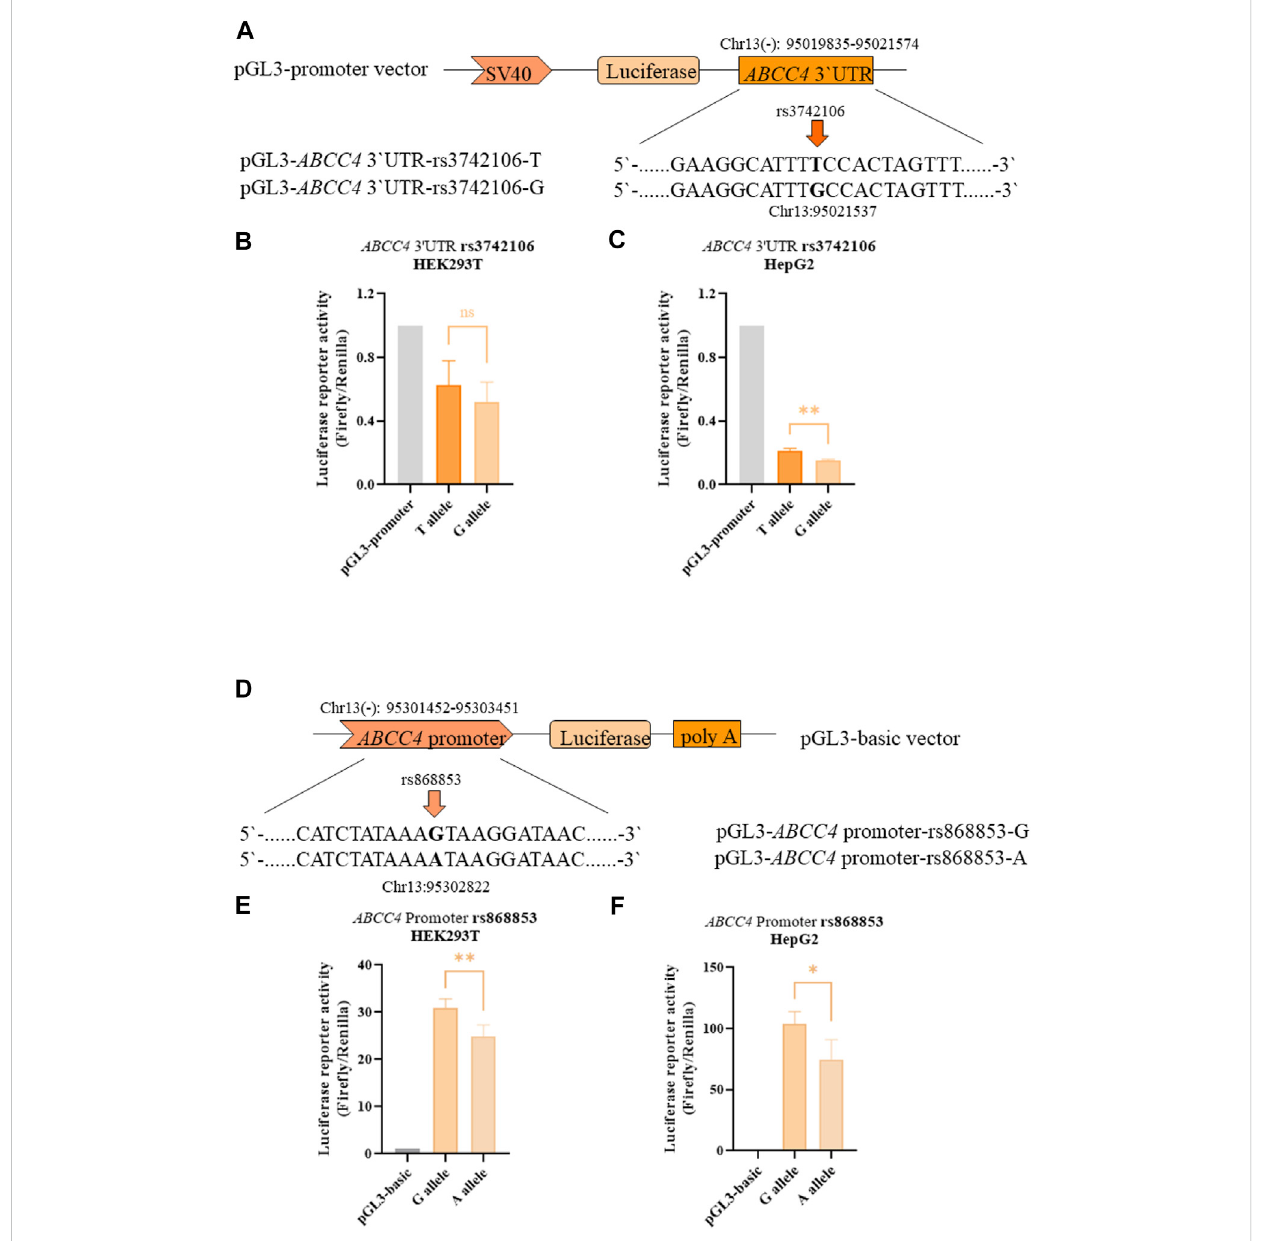
FIGURE 4 ABCC4 rs3742106 and rs868853 affect luciferase reporter activity. (A) Schematic representation of the ABCC4 3 ′ UTR expression plasmid and the positionofcorrespondingmutantsites.Fire fl yluciferaseconstructscontainedtheSV40promoter,luciferasecodingregionandafragmentofthe ABCC4 3 ′ UTR. The rs3742106 SNP polymorphism site is indicated by the arrow. Plasmid constructs were transfected into HEK293T (B) and HepG2 cells (C) . (D) Schematic representation of the ABCC4 promoter expression plasmid and the position of the corresponding mutant sites. Fire fl y luciferase constructs contained 2 kb fragment of the ABCC4 promoter, luciferase coding region and SV40 poly (A) . The rs868853SNP polymorphism site is indicated by the arrow. Plasmid constructs were transfected into HEK293T (E) and HepG2 cells (F) . Data represent the mean values of four independent experiments ±SD. Each experiment was conducted in triplicate. Ns indicates statistically non-signi fi cant; * p < 0.05, ** p < 0.01 were considered as signi fi